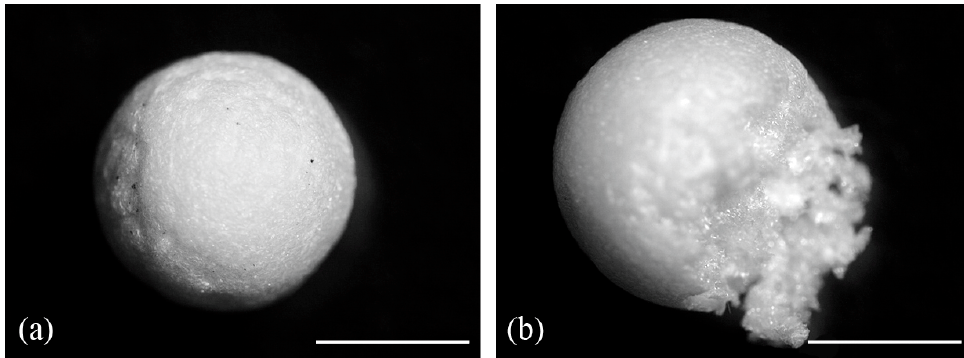
Figure 2. EPS pellet before grasping ( a ) and after grasping ( b ) by Anabas testudineus . Scale bar 2